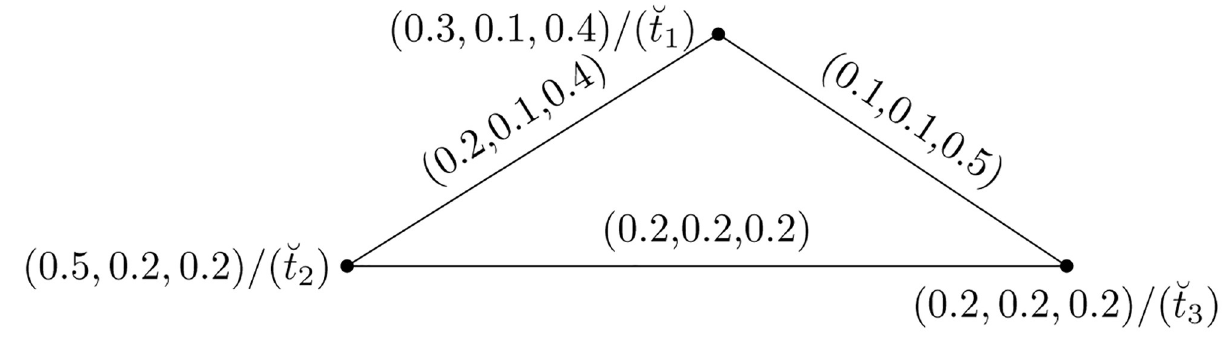
Fig 18. Picture fuzzy hypersoft graphs.